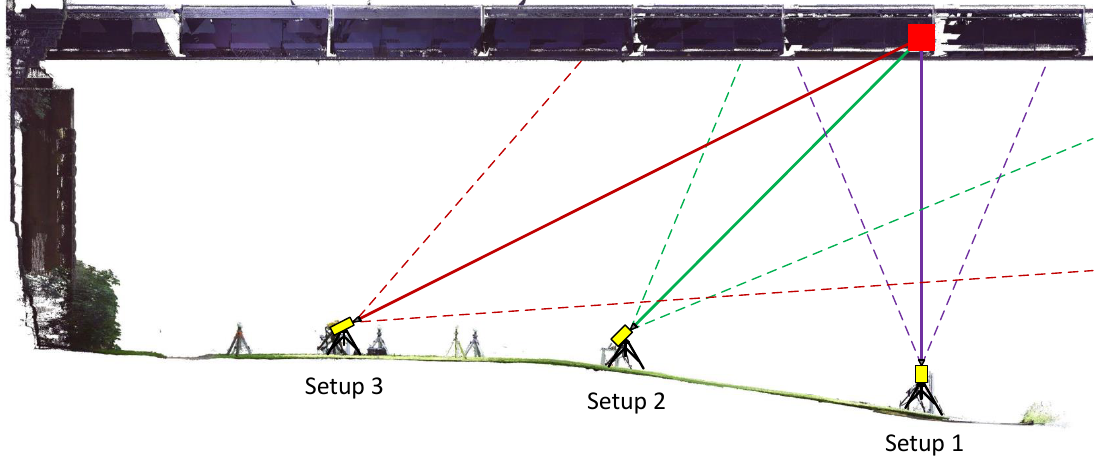
Figure 7. Side view of the bridge (laser scan) showing the schematic recording geometries of the 3